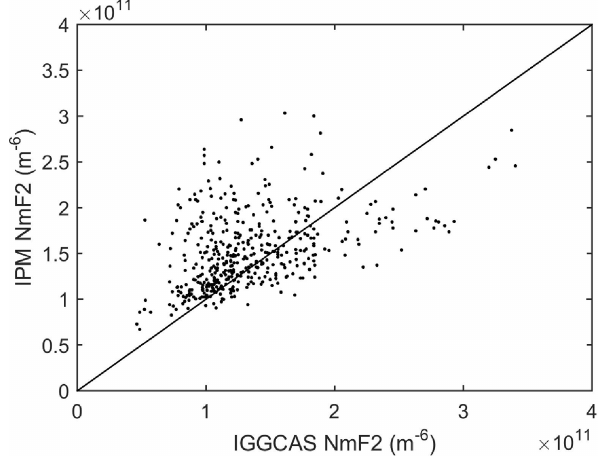
Figure 8. IPM-derived NmF 2 and IGGCAS ionosonde NmF 2 from 25 November 2017 to 8 May 2018. (The longitude difference be- tween the IPM substellar point and ionosonde stations is less than 12 ◦ , and the latitude difference is less than 5 ◦